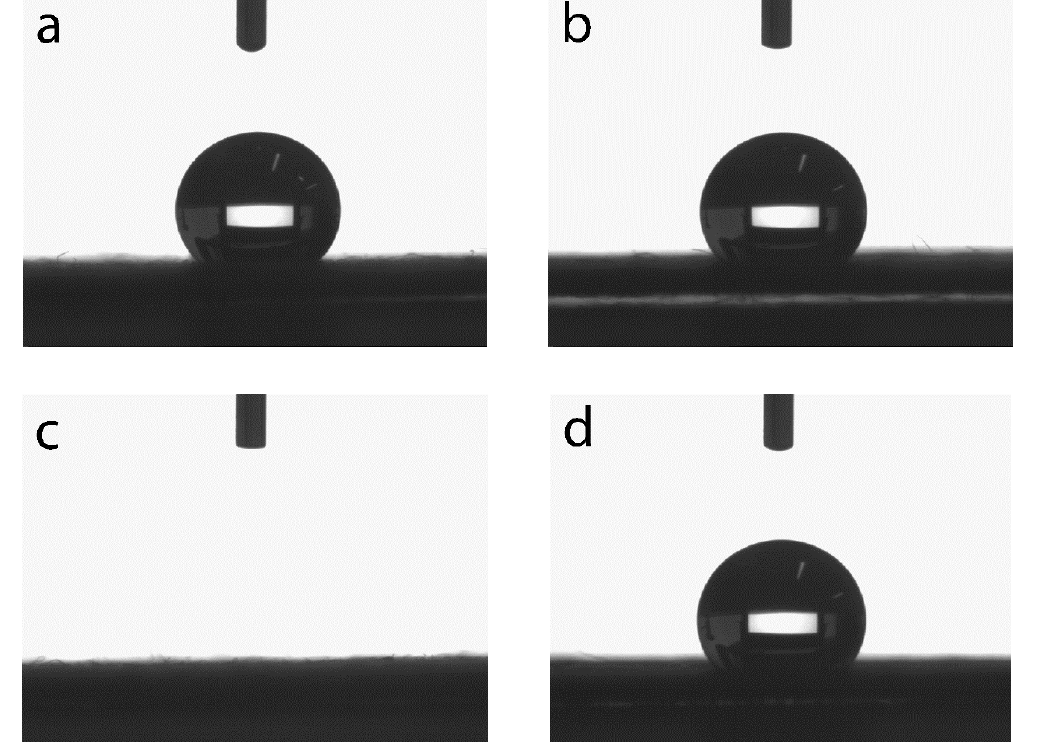
Figure 4. Contact angle diagram of the CC ( a ), N_CC ( b ), N_H_CC ( c ), and F_CC ( d ).